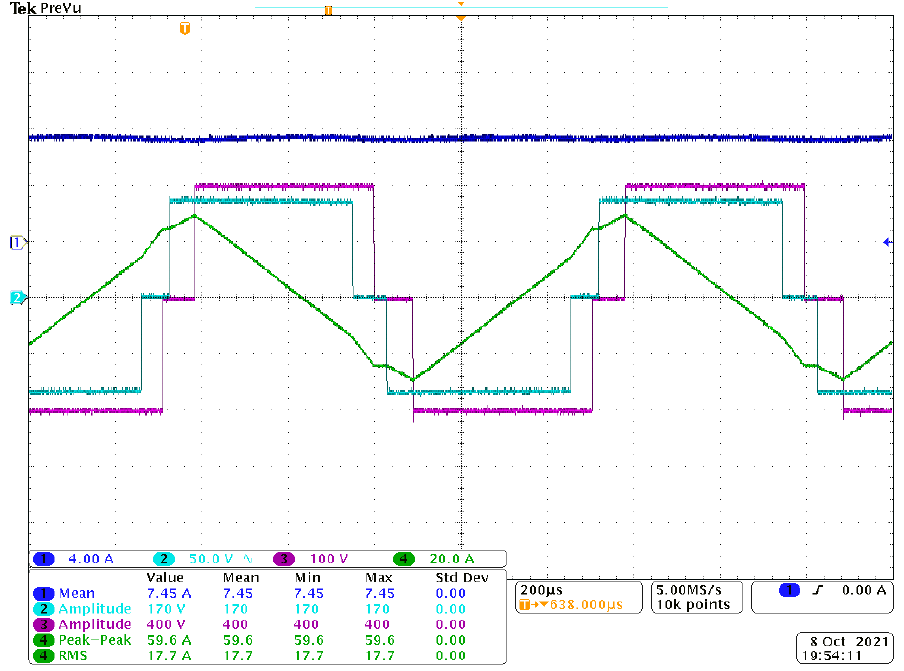
Figure 24. DAB operation at rated power under the TPS-based PLM.